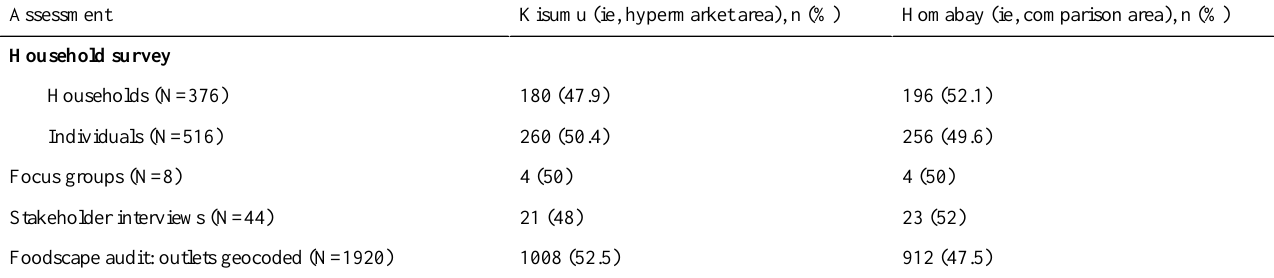
Table 1. Baseline assessment conducted in